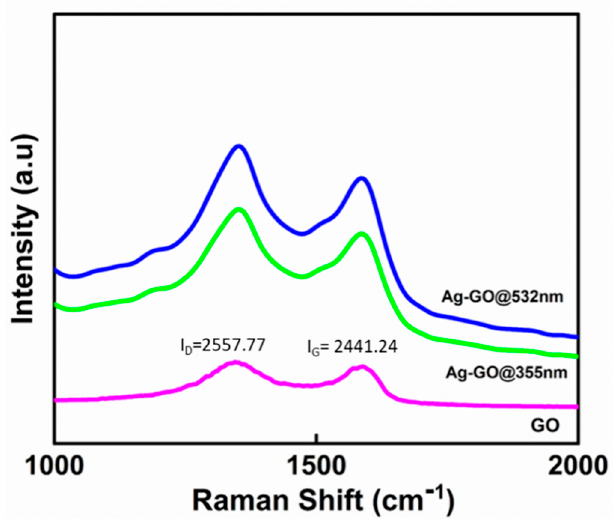
Figure 3. Raman spectra of the GO and Ag-GO nanohybrids.